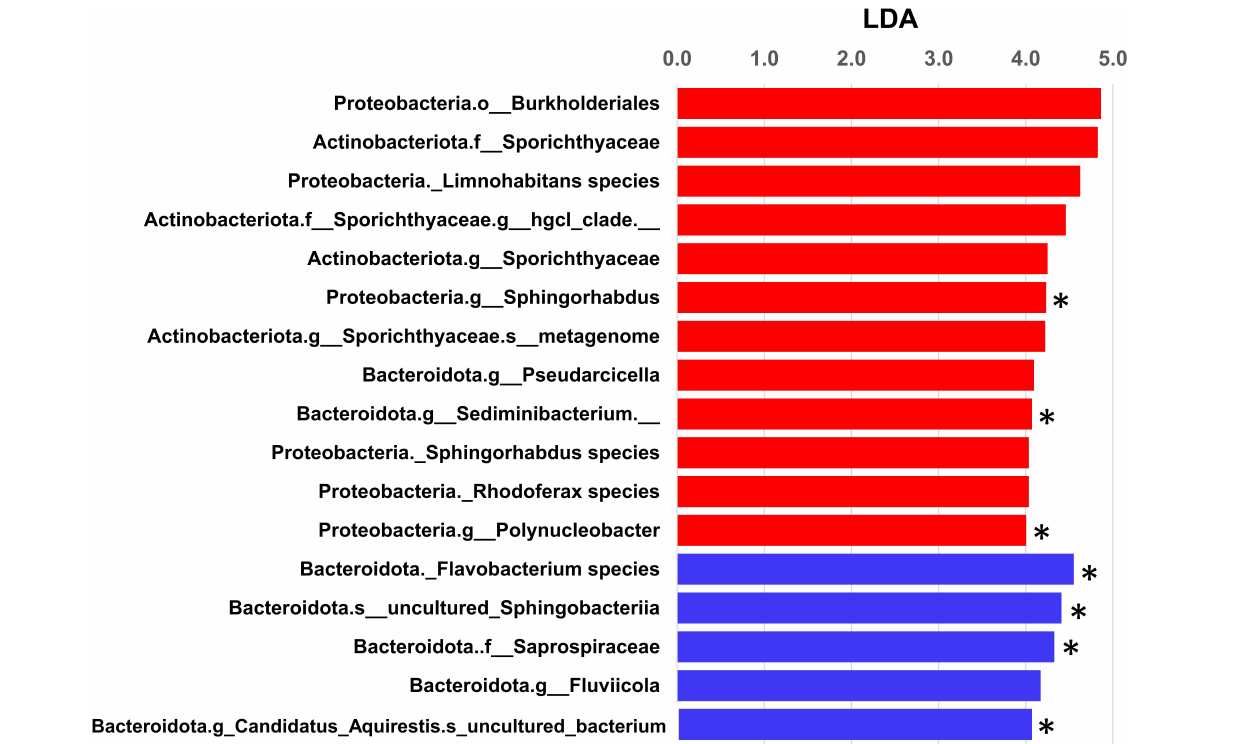
FIGURE 6 | Linear discriminate analysis effect size (LEfSe) analysis of bacterial communities from the two filter fractions analyzed (i.e., 0.22- and 5.0- µ m filters). Taxa differed significantly at all levels of taxonomic classification. Only taxa that could be assigned to the genus level with LDA effect sizes > 4.0 are shown in this graphical illustration (red and blue bars represent observed taxa in 0.22- and 5.0- µ m filters, respectively; ∗ denotes taxa that were significant by ANCOM). Overall, there were 986 taxa with LDA effect sizes greater than 2.0 ( Supplementary Table 1 ).